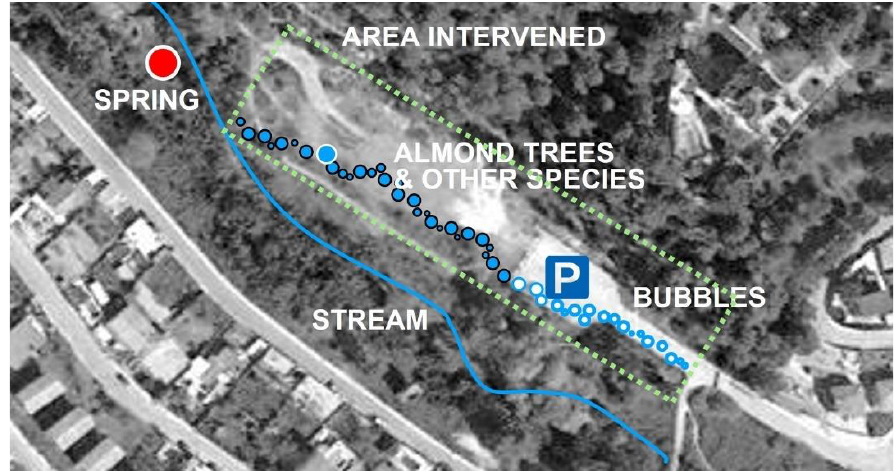
Figure 6. Masterplan of the interventions in the spring’s surroundings following the conclusion of the visual preference mapping (VPM) analysis (P indicates parking lot area). The bubbles are blue circles painted onto the surface of the car park, and the other circles are the positions of the painted logs.